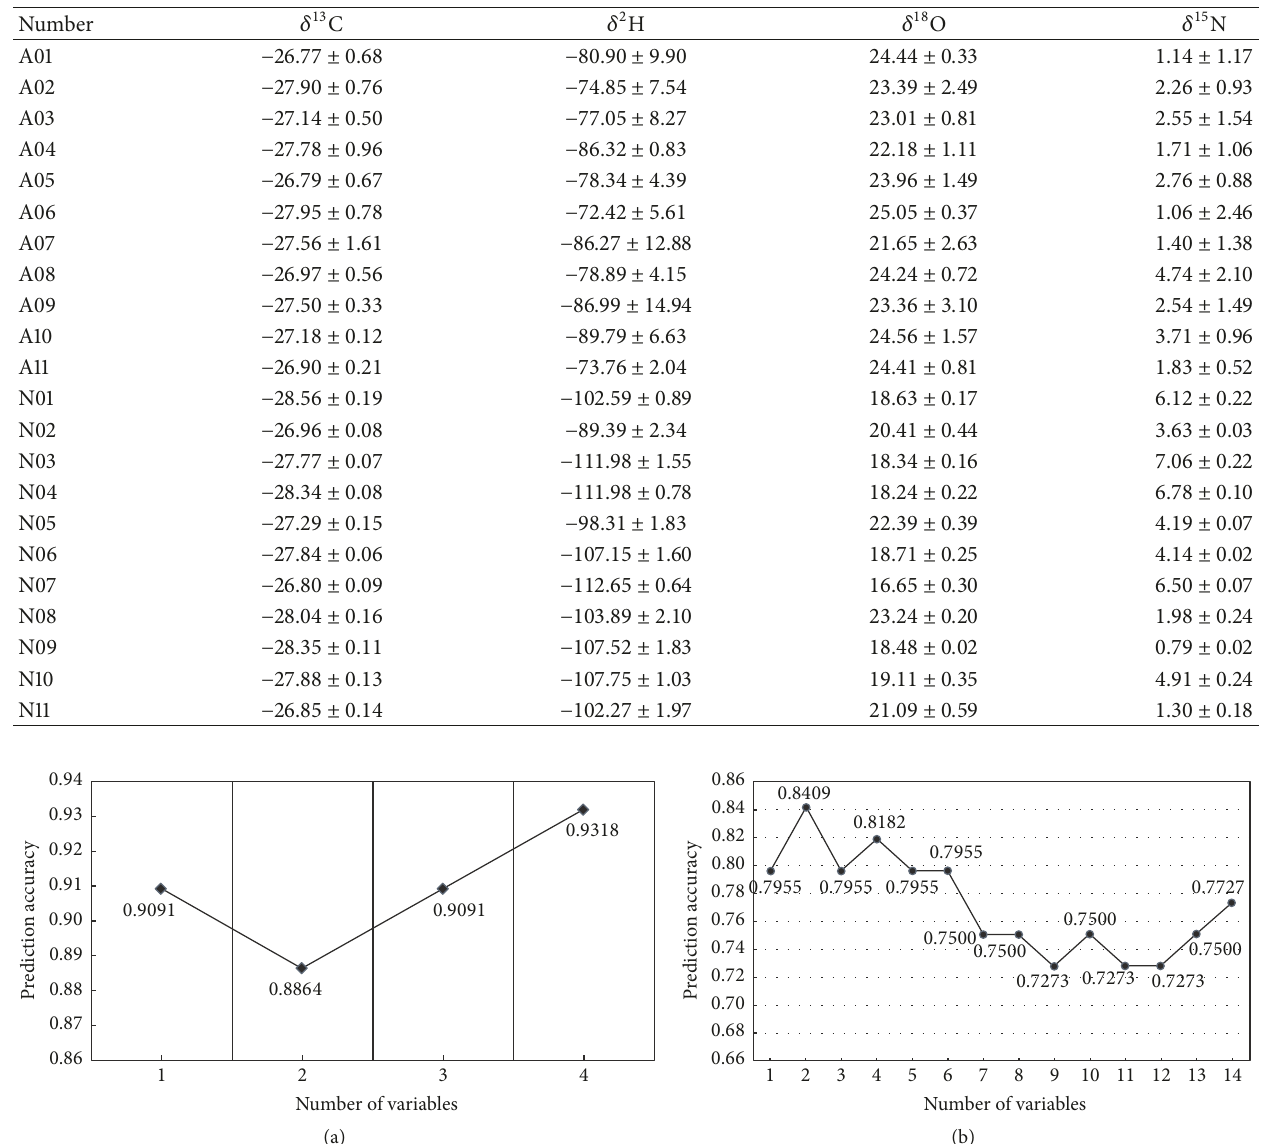
Table 4: Results of provenance experiment: averages values of 4 stable isotopes in WRT and NWRT samples.